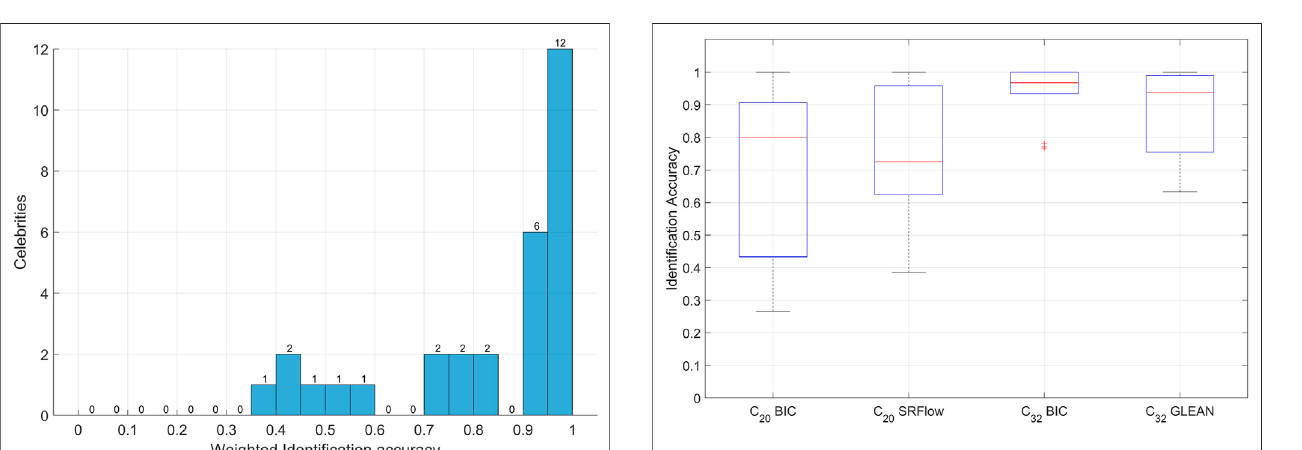
FIGURE 7 | Boxplot of the face recognition accuracies obtained for various celebrities separated according to the employed upsampling method and starting resolution. The red line indicates the median accuracy, the solid blue box includes 25-th to 75-th percentiles, the black dashed intervals include all elements that are not considered outliers, red crosses indicate outliers. The population size is 14 for the two boxes on the left and 16 for the two boxes on the